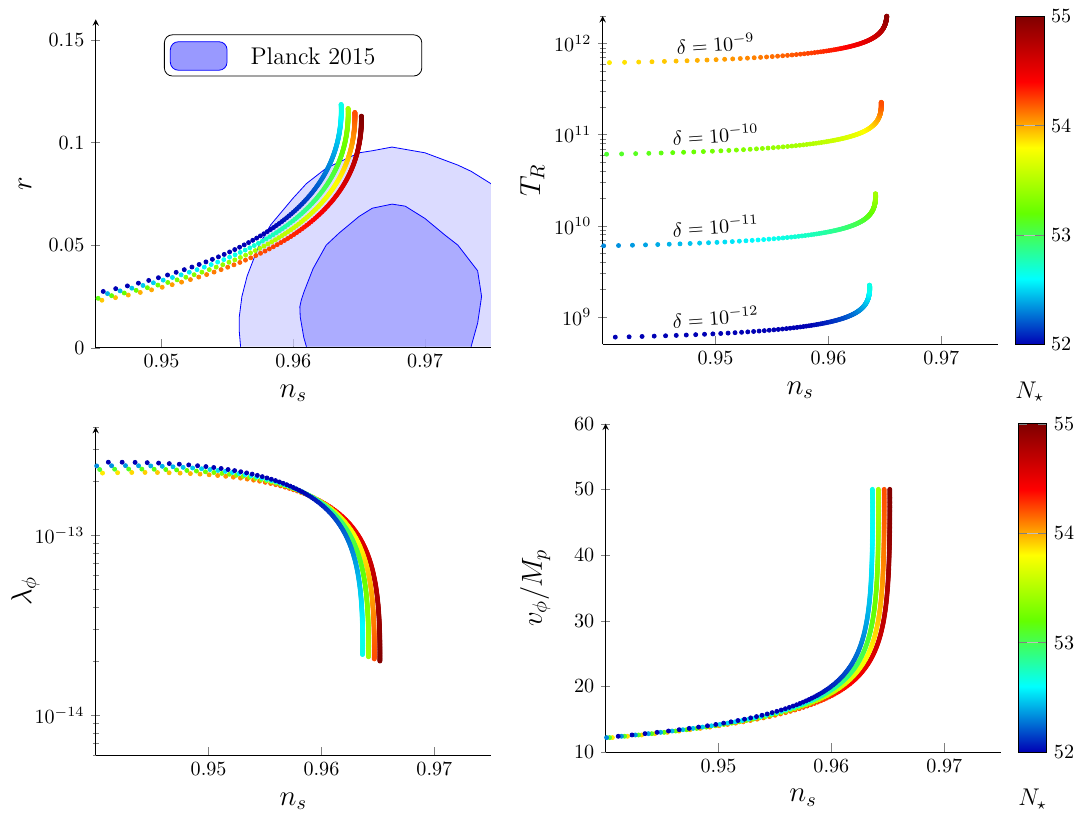
Figure 5 . From Top-left to bottom-right: tensor-to-scalar ratio, reheating temperature, quartic coupling and in(cid:13)aton vev, as functions of the spectral tilt n s , and parametrized by the number of e-folds N ? for di(cid:11)erent choices of (cid:14)